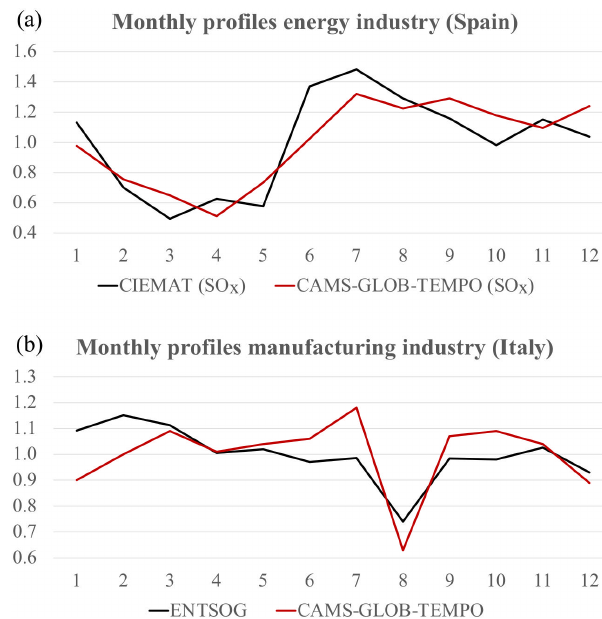
Figure 9. (a) Comparison between monthly temporal factors for SO x energy industry emissions derived from power plant emission measurements (CIEMAT, personal communication, 2018) and re- ported by CAMS-GLOB-TEMPO for Spain. (b) Comparison be- tween monthly temporal factors for manufacturing industry emis- sions derived from real-world measurements of industrial natural gas consumption (ENTSOG, 2020) and reported by CAMS-GLOB- TEMPO for